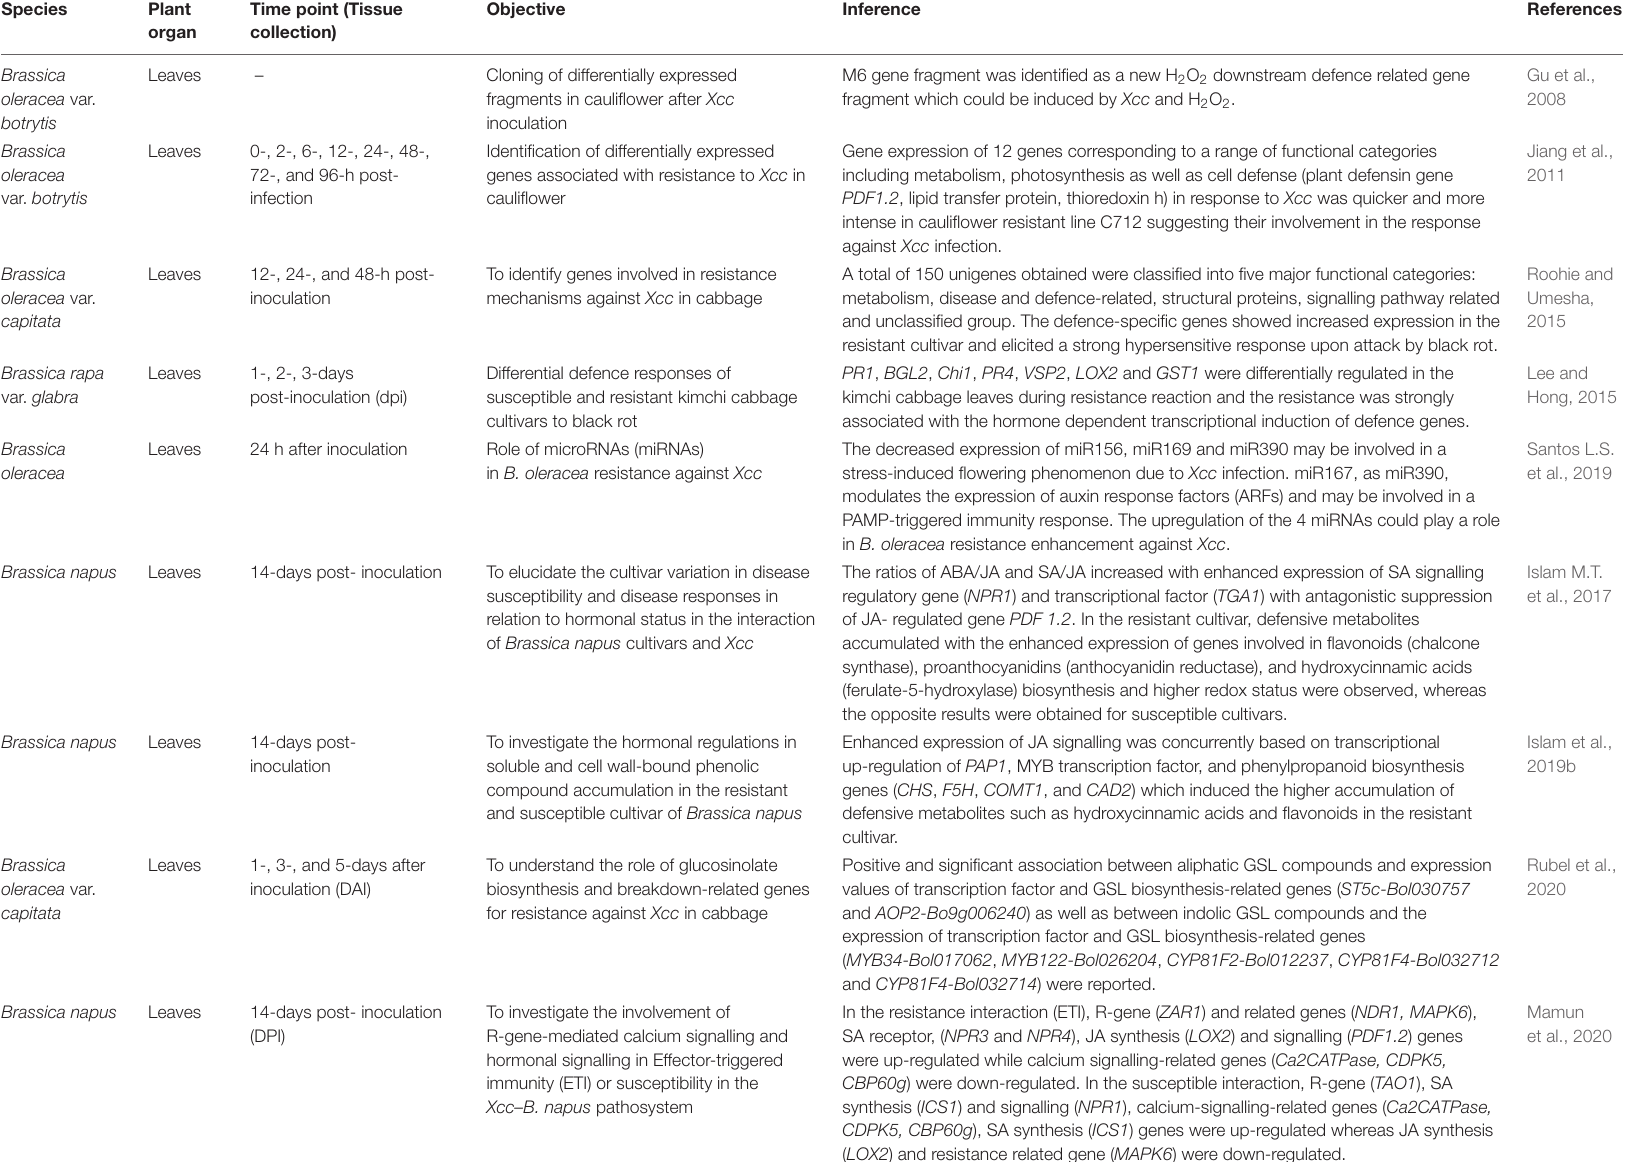
TABLE 3 | List of differential gene expression studies in Brassica species on black rot